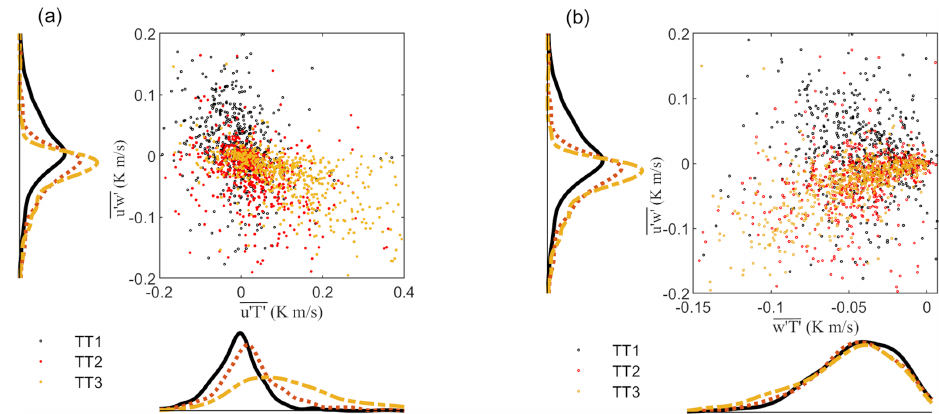
Figure 12. Streamwise horizontal turbulent heat flux plotted against streamwise momentum flux for stations TT1, TT2, and TT3 (a) . Vertical turbulent heat flux plotted against streamwise momentum flux for stations TT1, TT2, and TT3 (b) . Data are only shown for disturbed conditions and the 60 ◦ wind sector from 260 to 320 ◦ .